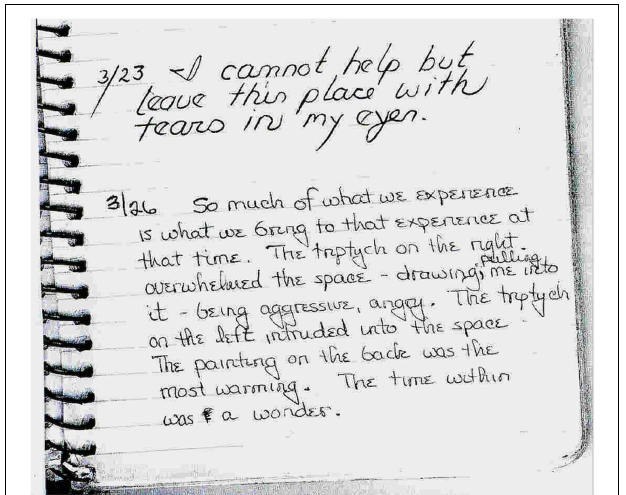
FIGURE 6 | Comments in the visitor’s log book noting crying and self-referential or experience-based interpretation of artwork meaning, Rothko Chapel, Houston Texas. (photo provided by curator to first author,